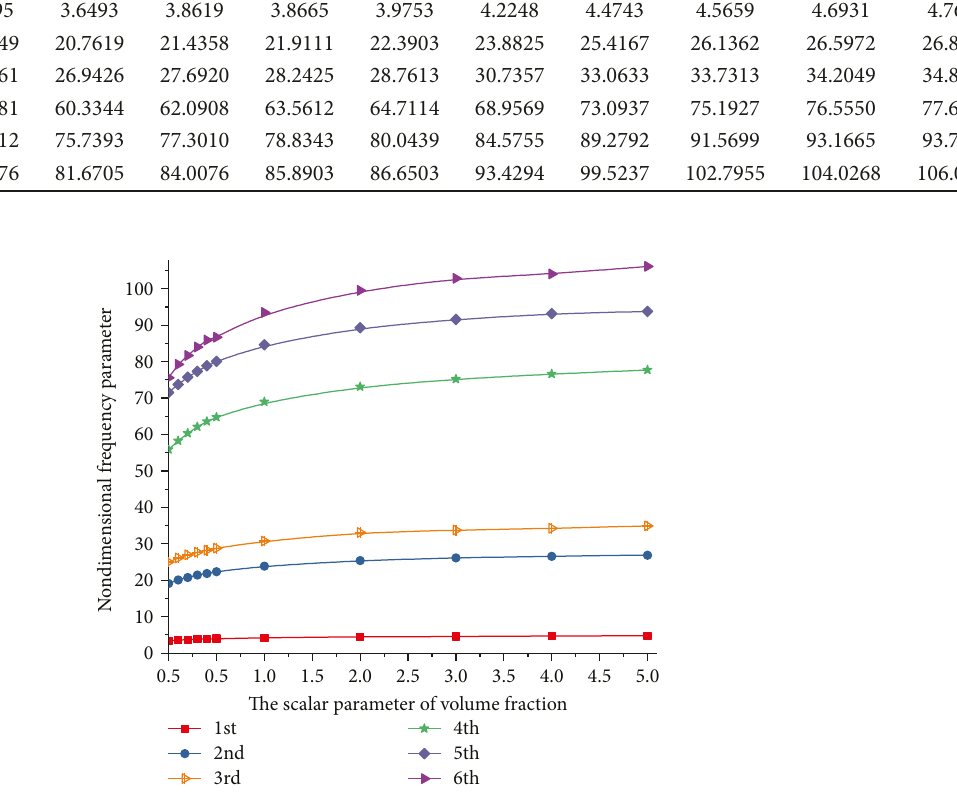
Figure 11: Variations of nondimensional frequency parameters withthe scalarparameter ofvolumefraction ( l = 3 , h = 20 , h